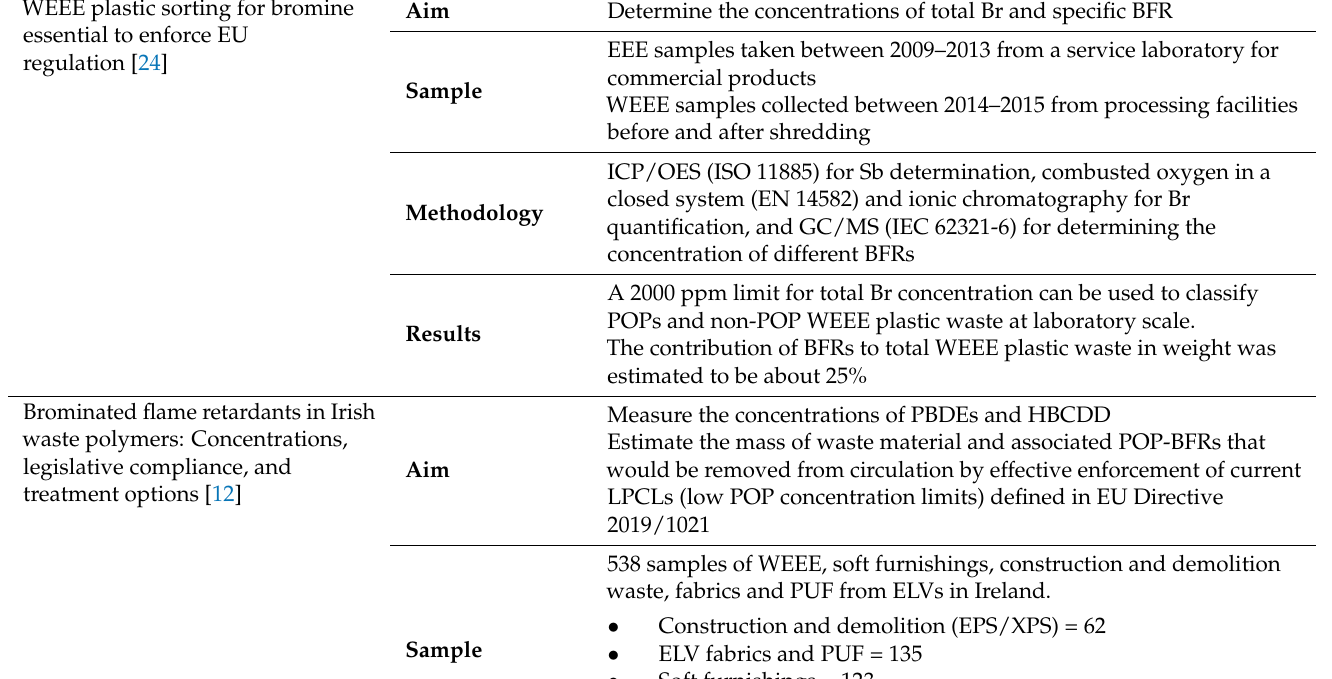
Table 4. Summary of recent studies on the determination of BFR concentration in WEEE